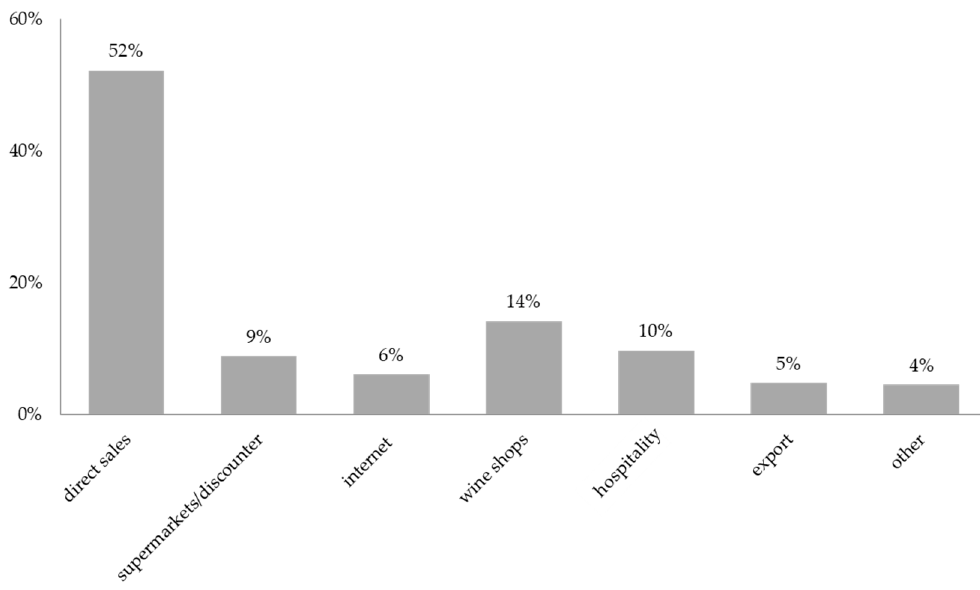
Figure 10. Average revenue contribution of German wineries by sales channel (survey results).